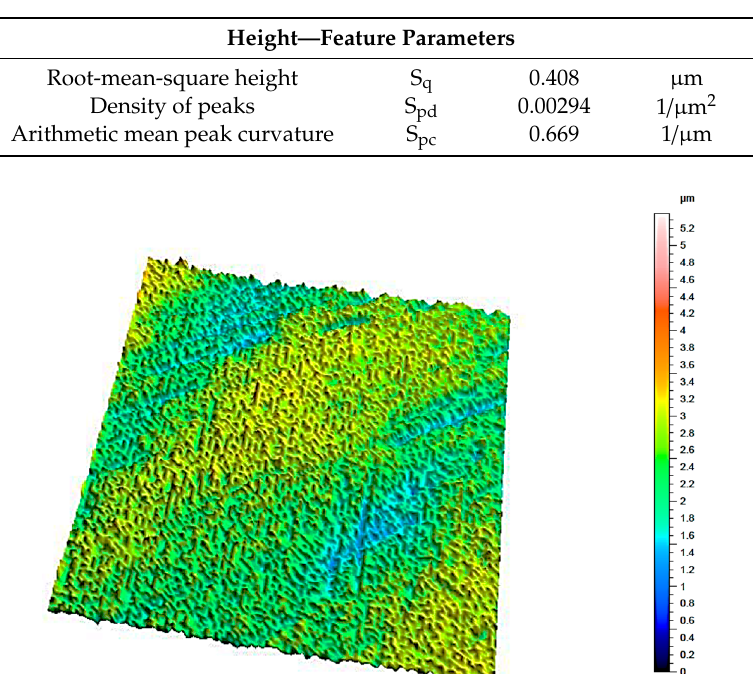
Figure 2. Surface asperities of the gear teeth.